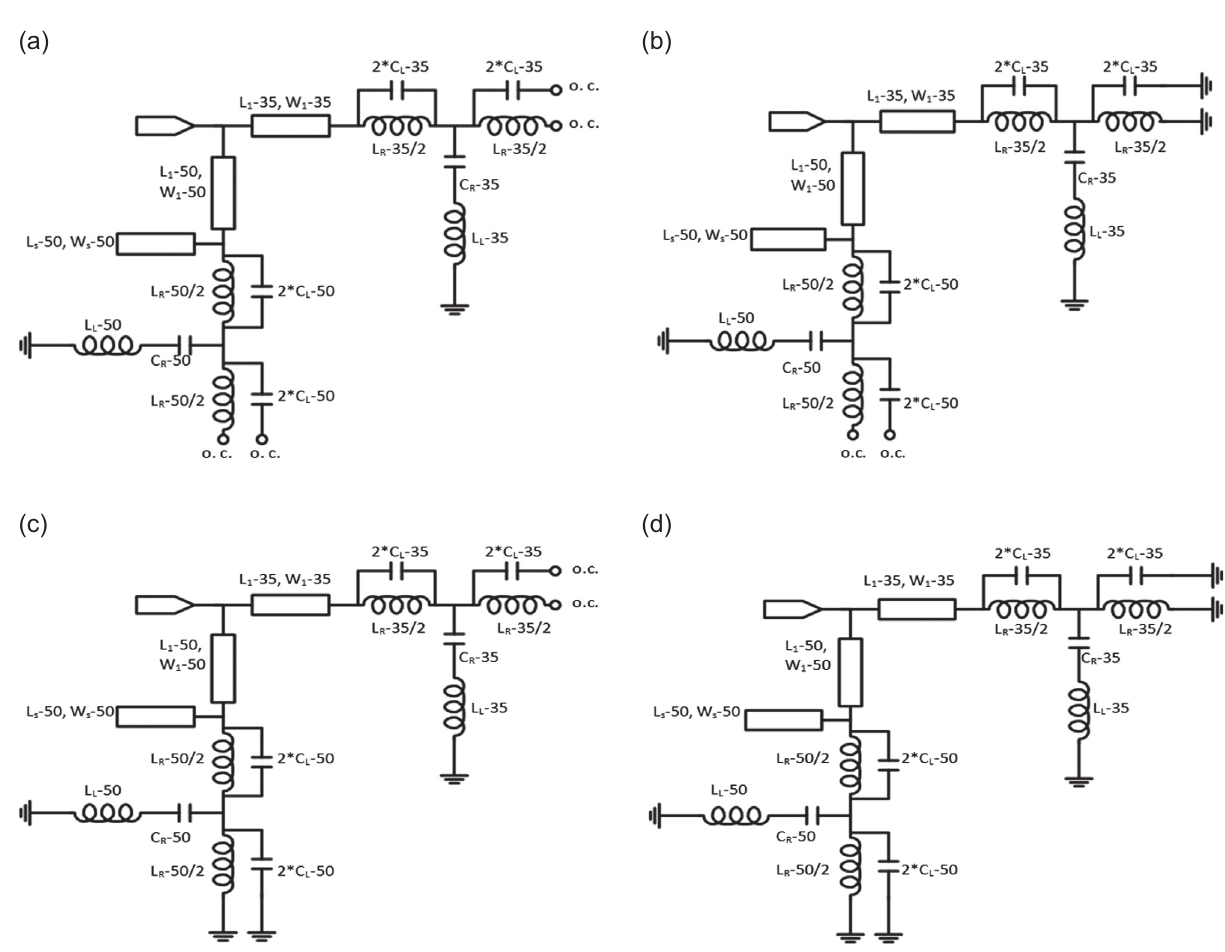
Figure 8. Reduced subcircuits (a) even-even (b) even-odd (c) odd-even (d) odd-odd for L R -35 = 0.87 nH, C R -35 = 0.8 pF, L L -35 = 12 nH, C L -35 = 10.2 pF, L 1 -35 = 16.3